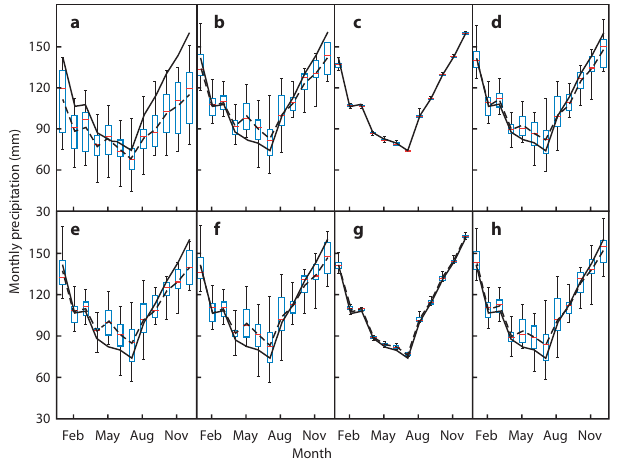
Fig. 4. Monthly mean precipitation over the Montford catchment evaluated over the time period 1961–2000. Boxplots denote the 25 and 50 percentiles where the whiskers are the upper and lower of the RCM values. The dashed line show the mean of the RCM data of (a) raw RCM output, and with MOS using (b) QM, (c) QM-M, (d) QM-L, (e) DM, (f) DBS, (g) DBS-M and (h) DBS-L. The black solid line shows the observed monthly mean